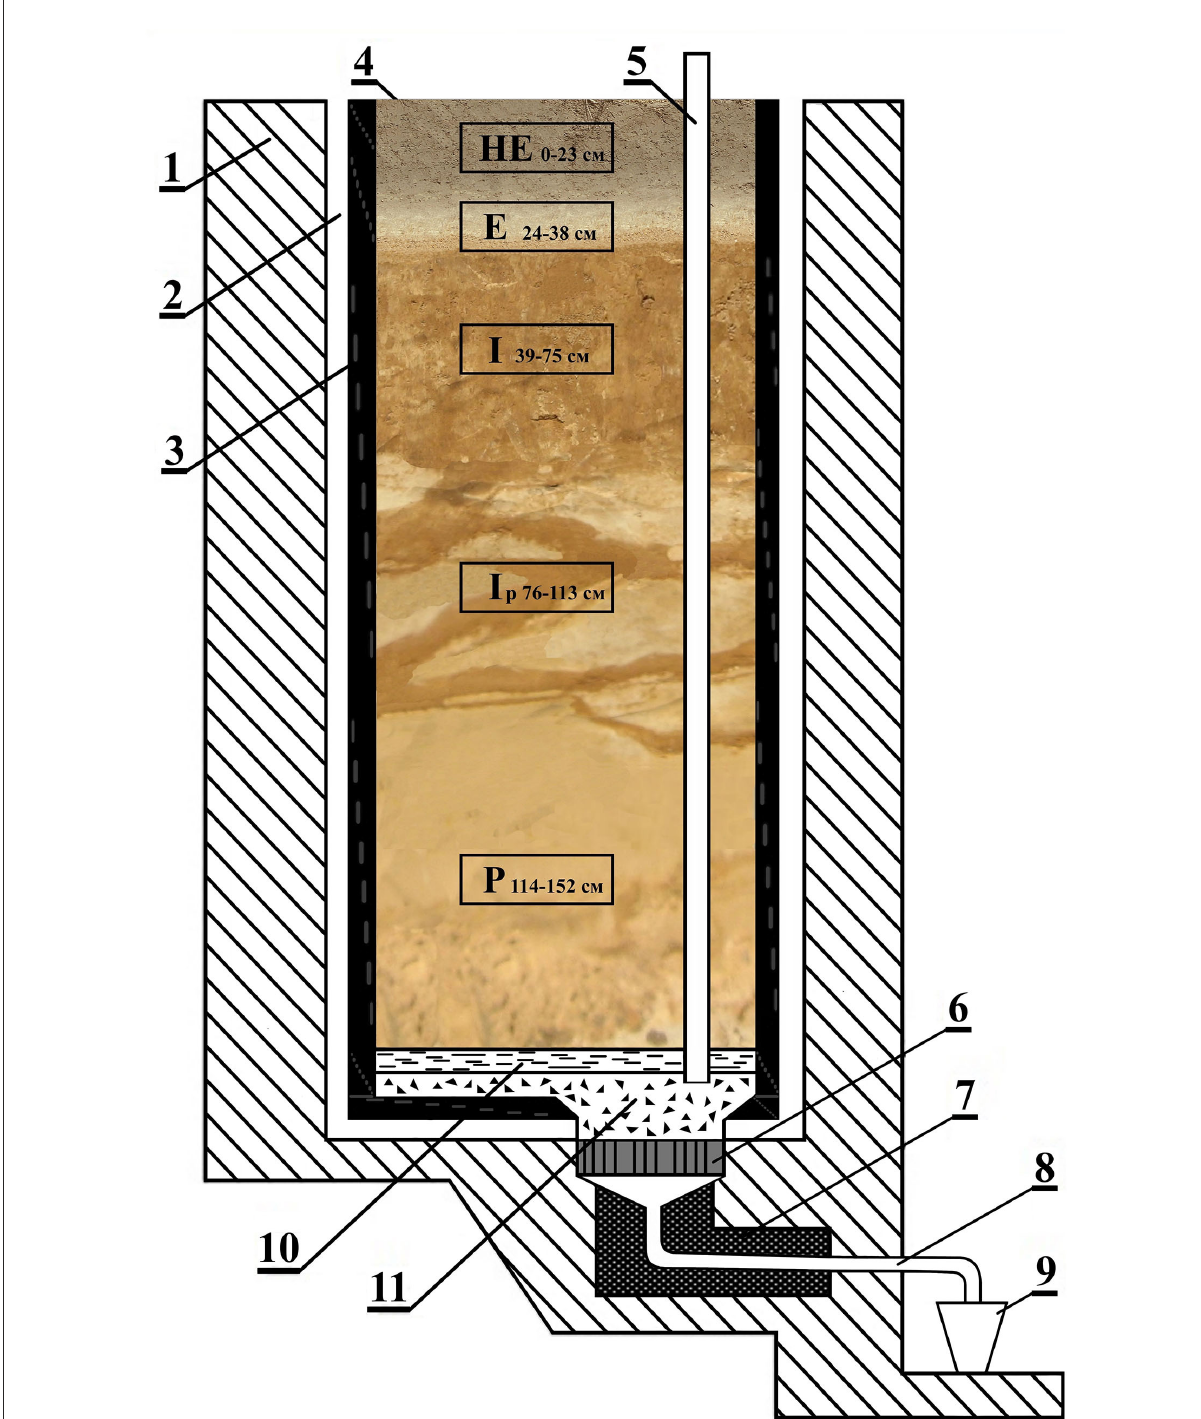
FIGURE1 The scheme of vertical cut of lysimeter packed with soil. 1 — outer wall (concrete); 2 — hydro isolation (3cm); 3 — inner isolation wall (4cm); 4 — soil (considering the depth of genetic horizons); 5 — drainage vertical pipe; 6 — drainage disk; 7 — mineral wool; 8 — drainage pipe; 9 — container for leachate collection; 10 — river sand; 11 — crushed glass